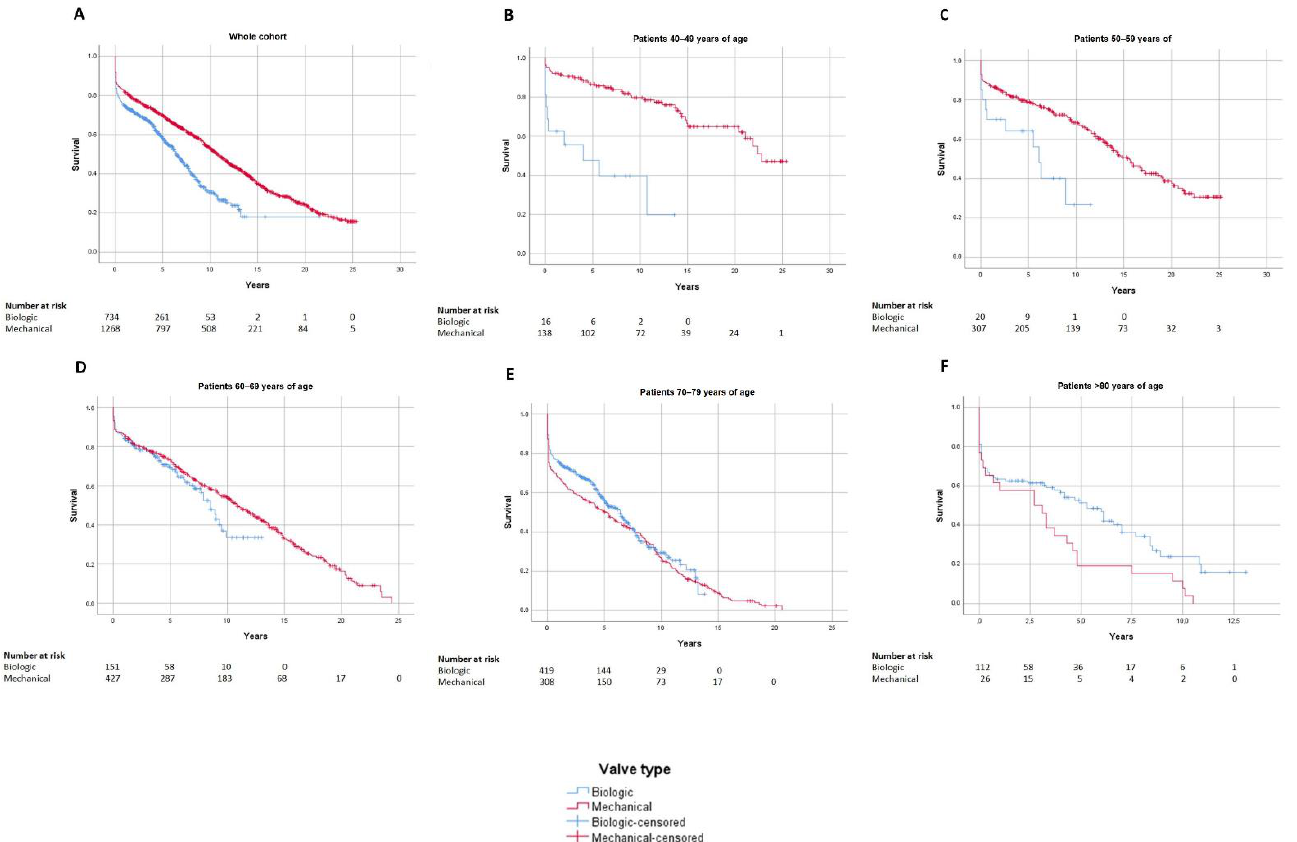
Figure 2. ( A ) Cumulative survival after mitral valve replacement with a biological or mechan- ical prosthesis in patients between 40–49 years ( p < 0.001) ( B ), in patients between 50–59 years Figure 2. Cumulative survival after mitral valve replacement with a biological or mechanical pros- ( p = 0.001) ( C ) and in patients between 60–69 years ( D ). No difference can be observed in patients thesis in patients between 40 – 49 years ( p < 0.001), in patients between 50 – 59 years ( p = 0.001) and in between 70–79 years ( E ). No difference can be observed in patients above 80 years ( p = 0.014) ( F ). patients between 60 – 69 years. No difference can be observed in patients between 70 – 79 years. No MVR = mitral valve replacement. difference can be observed in patients above 80 years ( p = 0.014). MVR= mitral valve replacement.